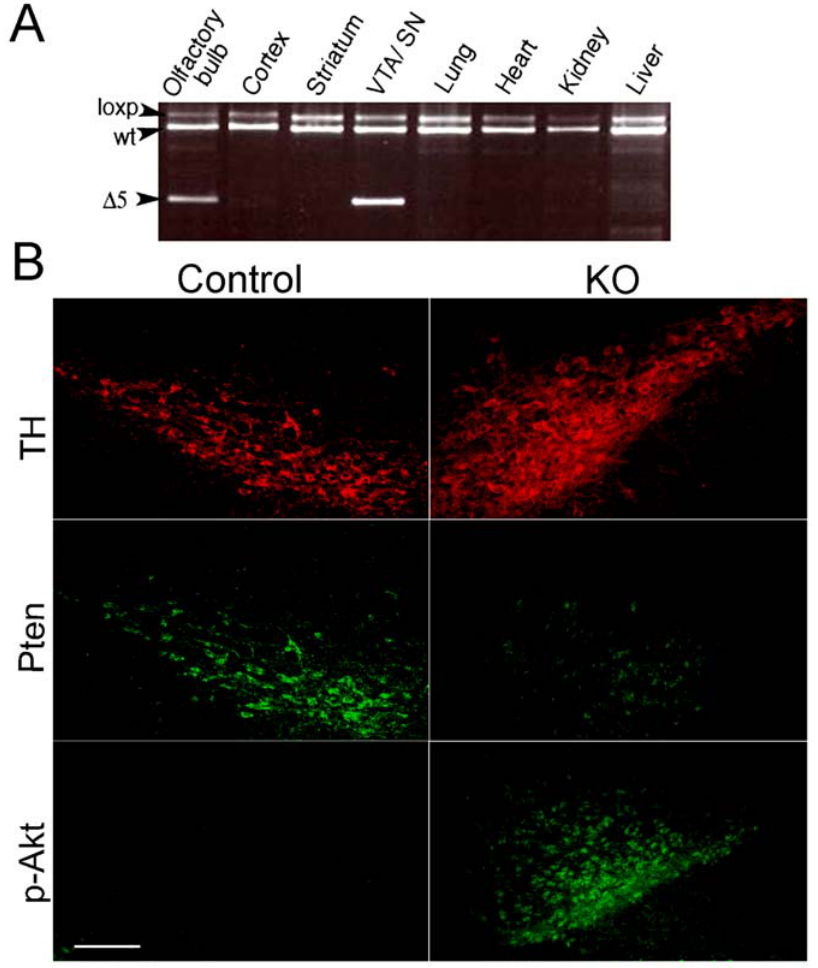
Figure 1. Cre recombinase deletes Pten exon 5 in neurons expressing the dopamine transporter. (A) PCR screen for Cre-mediated Pten exon5 deletion. Genomic DNAs were prepared from the indicated brain tissues from a Pten loxP/loxP /Cre/wt adult mouse. PCR analysis show Pten deletion (delta5) is specific to the olfactory bulb and SN/VTA. Pten deletion could not be detected in other brain areas analyzed. (B) Immunofluorescent staining shows TH and PTEN staining in the ventral mesencephalon of control and Pten KO animals. In the mutant animals, loss of PTEN activity is associated with increased TH and membrane phospho-AKT staining. Sections correspond to Bregma -2.95 mm with reference to Franklin and Paxinos (1997). Scale bar, 250 m